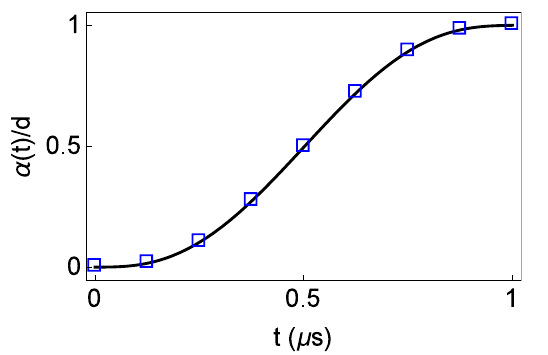
Figure 4. Scaled trajectory α , Eq. (30), of the center of the trap in a double well launching protocol with parameters λ = − . 4 7 pN/m, β = . 5 2 mN/m 3 , µ = . 86 4 zN, = d 370 μ m, γ = 3 and = t 1 = v 10 m/s and ε = s 2/ . Blue rectangles mark the points of the trajectory in which a snapshot of the potential is f depicted in Fig.